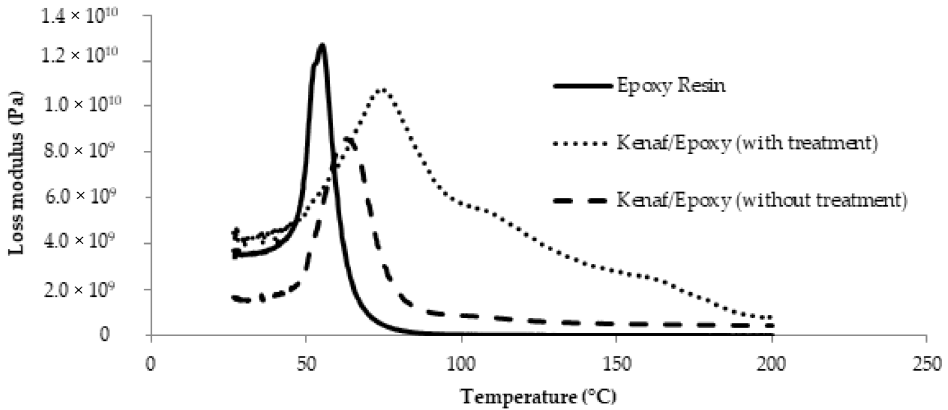
Figure 12. Loss modulus spectra for epoxy composite reinforced with untreated and treated kenaf fiber.